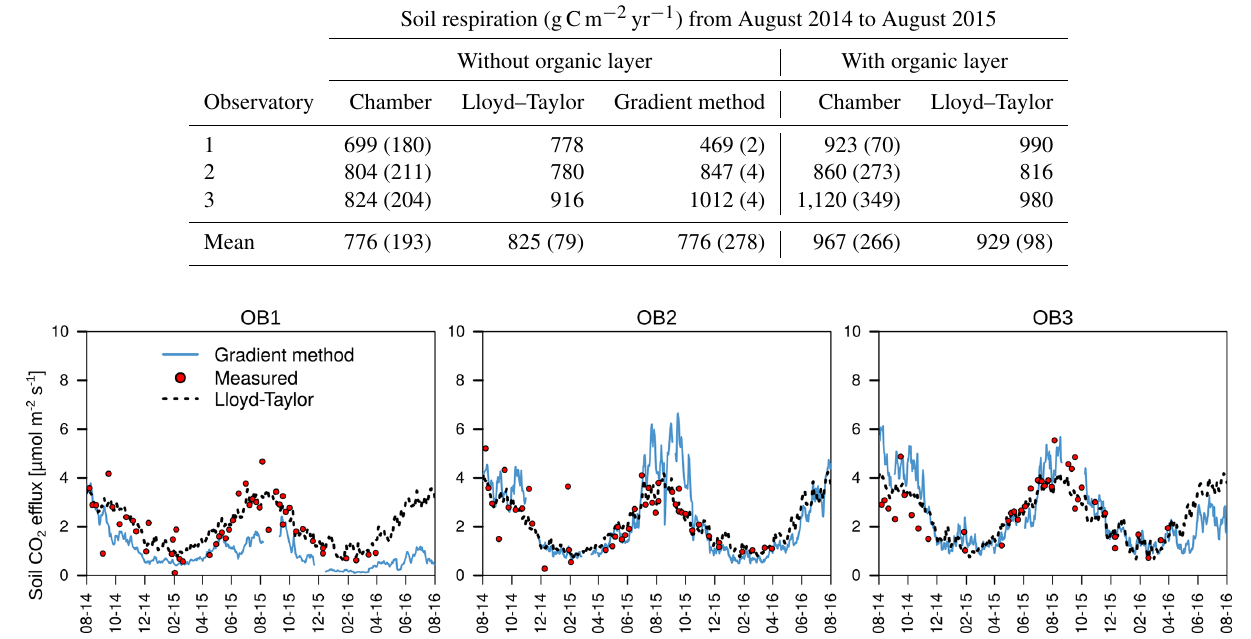
Table 1. Total soil respiration with and without the organic layer for the three observatories derived from soil surface measurements with linear interpolation (chamber), modelled with a Lloyd–Taylor function and derived from the gradient method based on CO 2 measurements along the soil profile for 1 year. Means and standard deviations are shown.